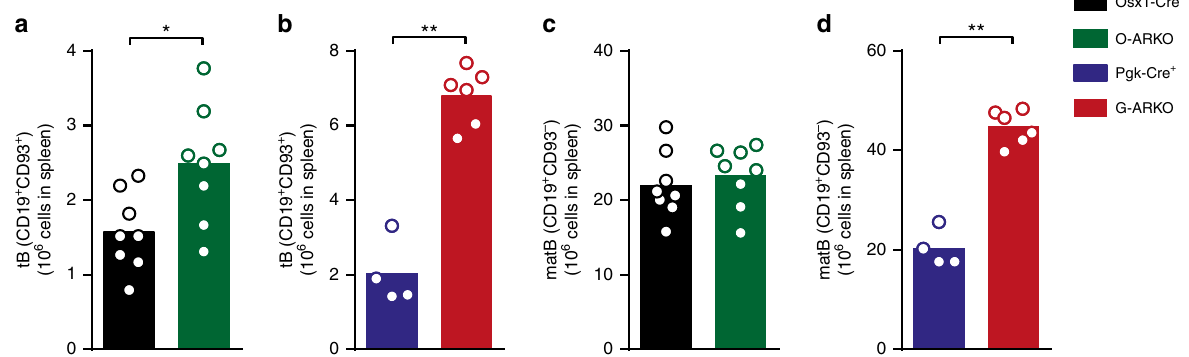
Fig. 2 Splenic mature B cell number is unaltered in O-ARKO mice. a Number of CD19 + CD93 + transitional B (tB) cells in spleen from control ( Osx1-Cre + ) and osteoblast lineage-speci fi c androgen receptor knockout (O-ARKO) male mice. n = 8/group. b tB cells in spleen from control ( Pgk-Cre + ; n = 4) and general androgen receptor knockout (G-ARKO; n = 6) male mice. c CD19 + CD93 – mature B cells (matB) in spleen from control and O-ARKO mice. d matB cells in spleen from control and G-ARKO mice. All bars indicate means; circles represent individual mice. * P < 0.05, ** P < 0.01 (Mann –